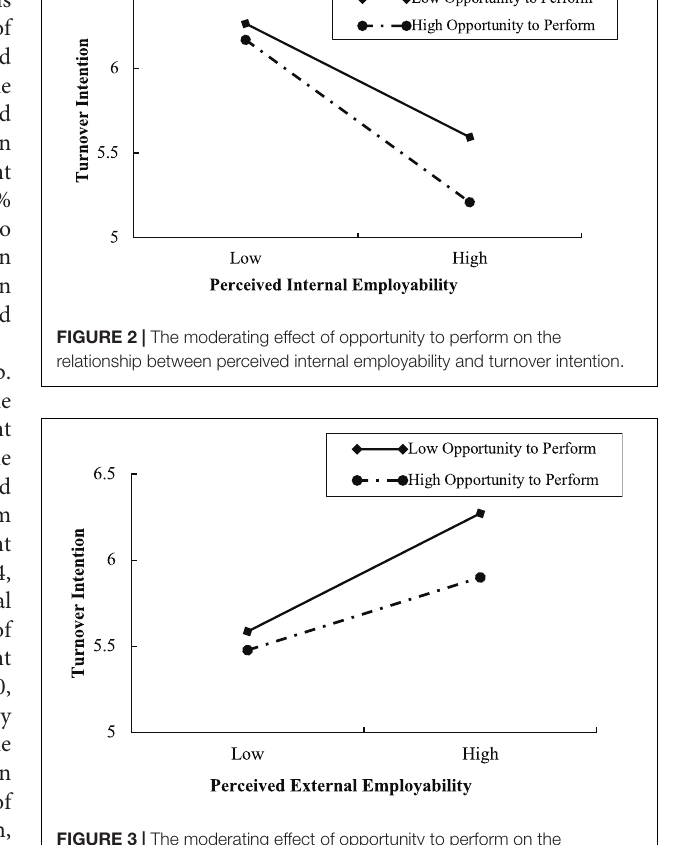
FIGURE 3 | The moderating effect of opportunity to perform on the relationship between perceived external employability and turnover